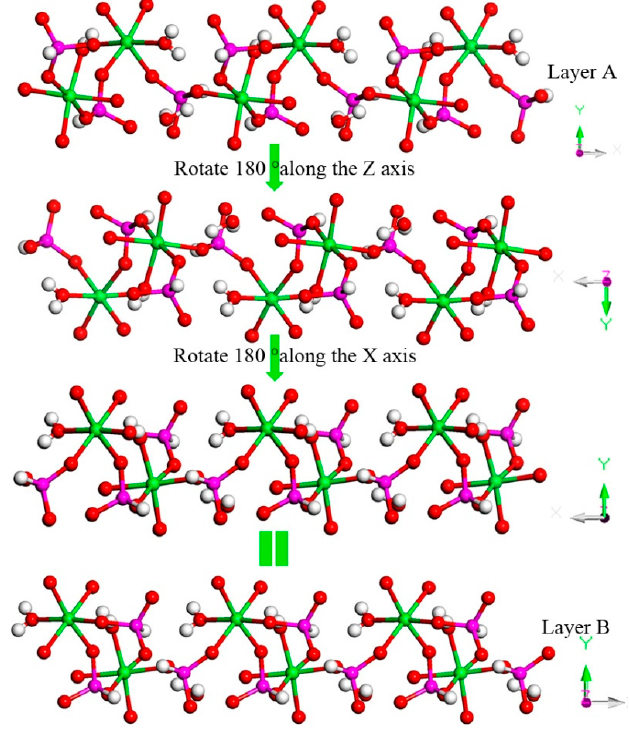
Figure 11. The relationship between AB layers. P, pink; In, green; H, white; O, red .